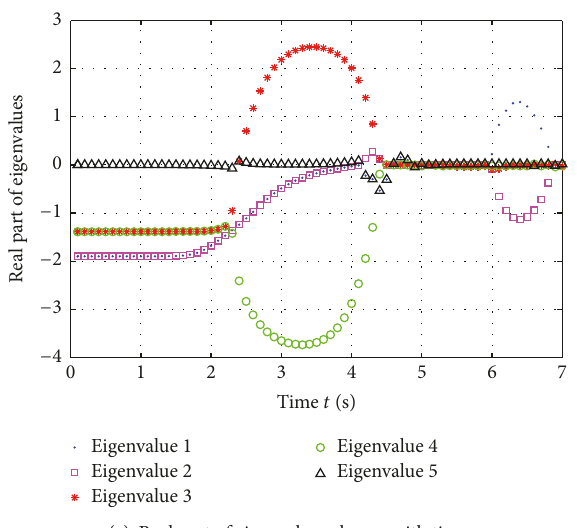
Figure 6: Changes in steering angle, lateral velocity, and real parts of calculated eigenvalues with 𝐴